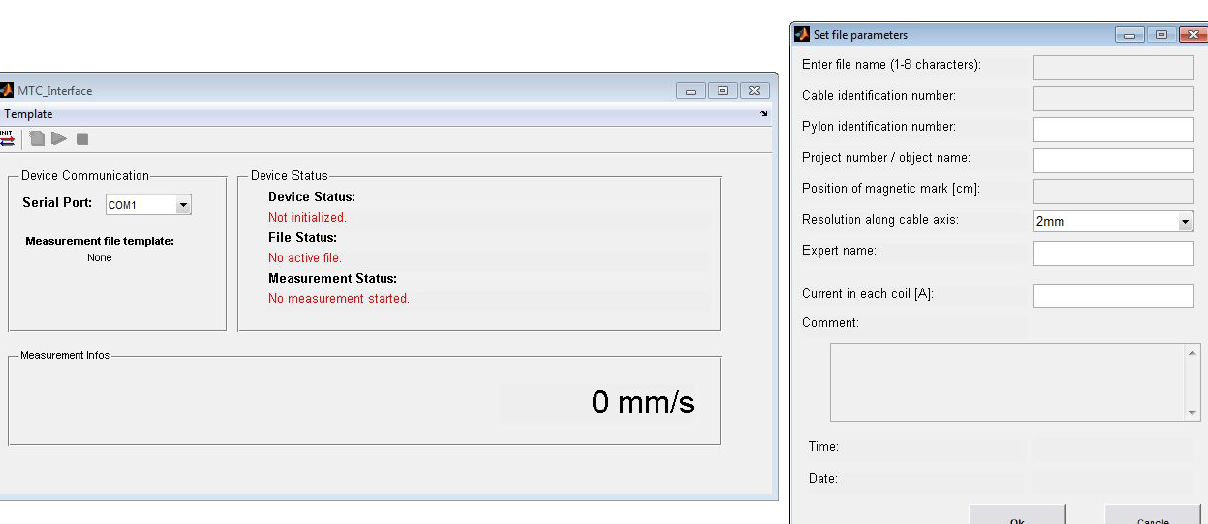
Figure 6. File header form in the device interface